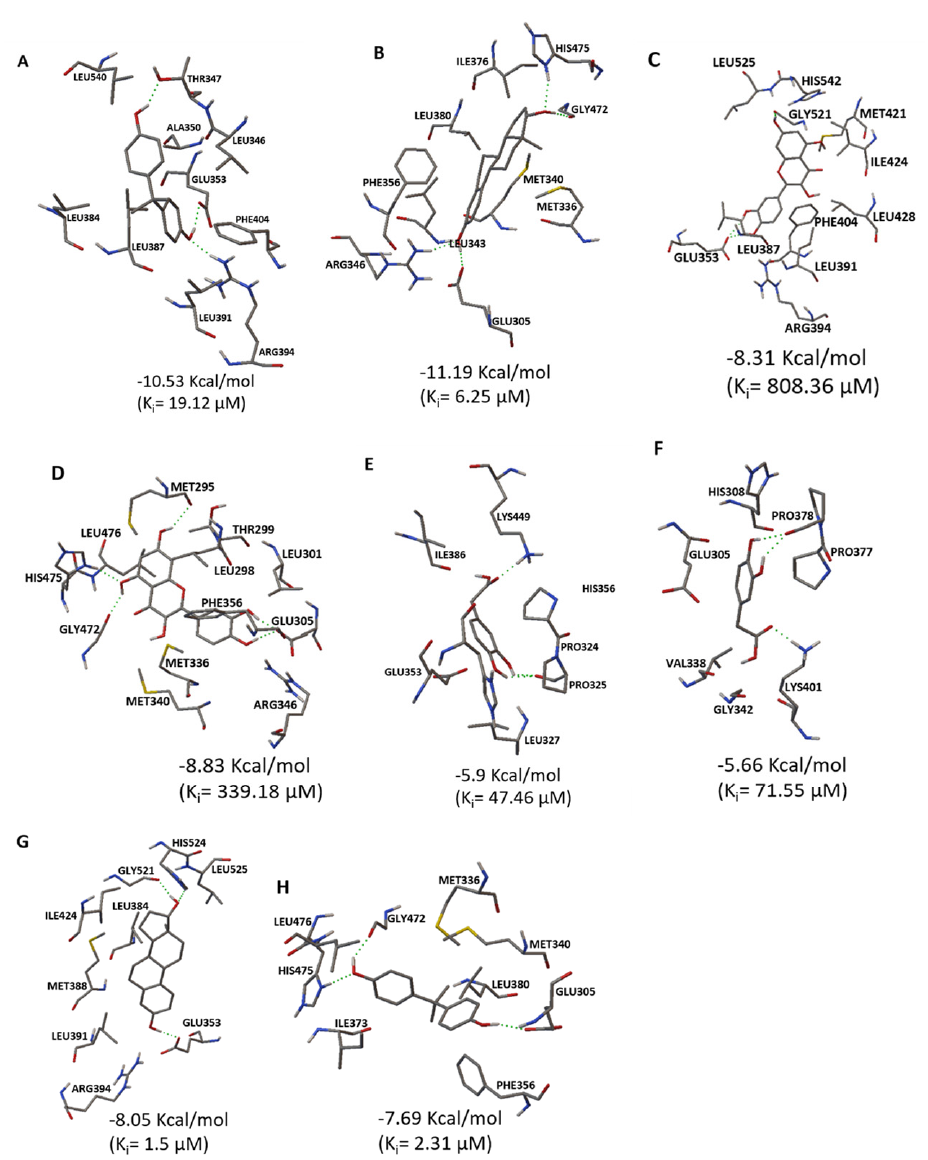
Figure 8. in silico molecular coupling analysis between ligands and receptors. The best coupling bond between ( A ) 17— β estradiol—ER α , ( B ) 17- β estradiol—ER β , ( C ) Q—ER α , ( D ) Q—ER β , ( E ) DOPAC— ER α , ( F ) DOPAC—ER β , ( G ) BPA—ER α , and ( H ) BPA—ER β . The image represents the interaction between ligands and receptor amino acids. The ∆ G values indicate the binding energy expressed in kcal/mol. The inhibition constant (Ki) for each interaction is expressed in µ